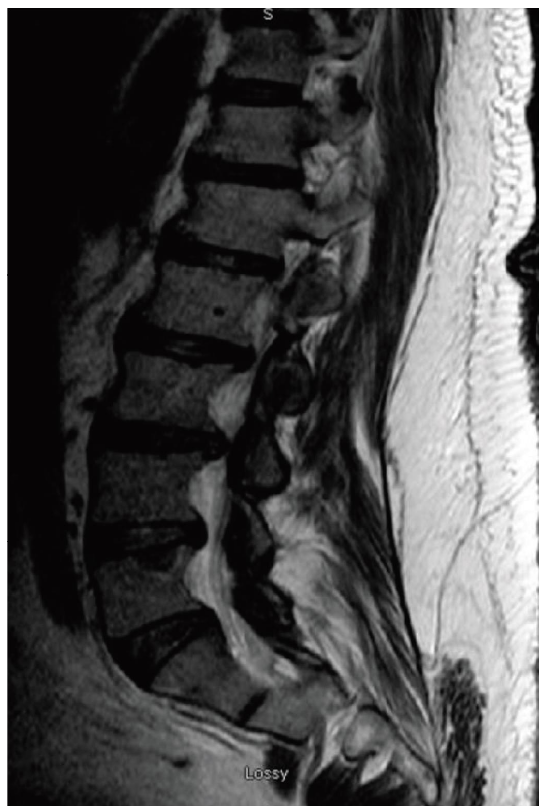
Figure 4: MRI lumbar spine.